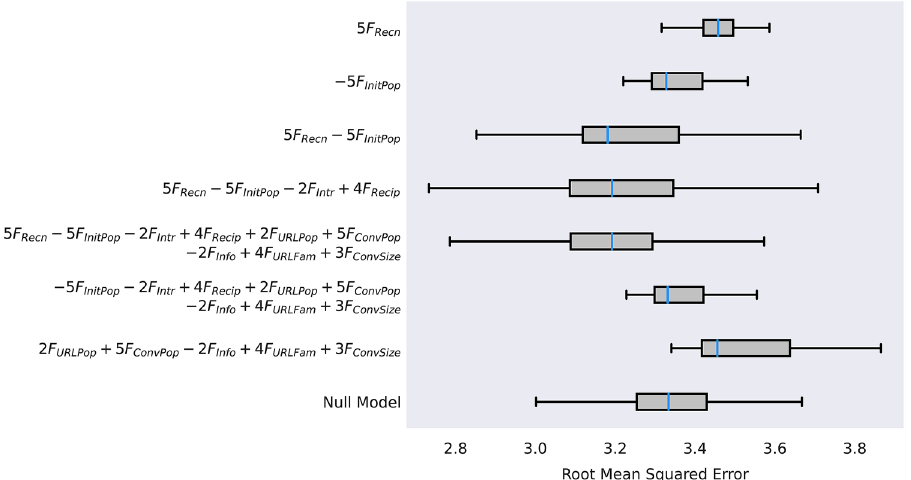
Figure 6. 100 runs of MACM-IOM with response prioritization rules inferred through evolutionary model discovery. Simulations of models derived from evolutionary model discovery insights are compared against a null model with random message prioritization. Each model was run 100 times. Only models that include both F Recn and F InitPop have a lower median RMSE than that of the null model.